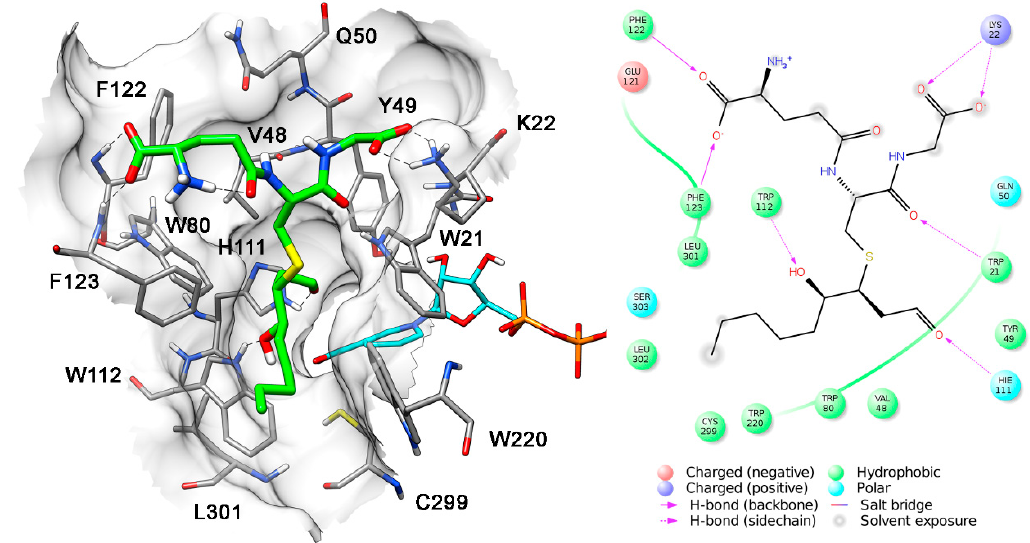
Figure 5. Interaction of h AR1B1 and 3S,4R- GSHNE. The minimized average structure of 3 S, 4 R- GSHNE docked into the h AKR1B1 active site is reported. All interactions between the GSHNE and enzyme residues are shown.